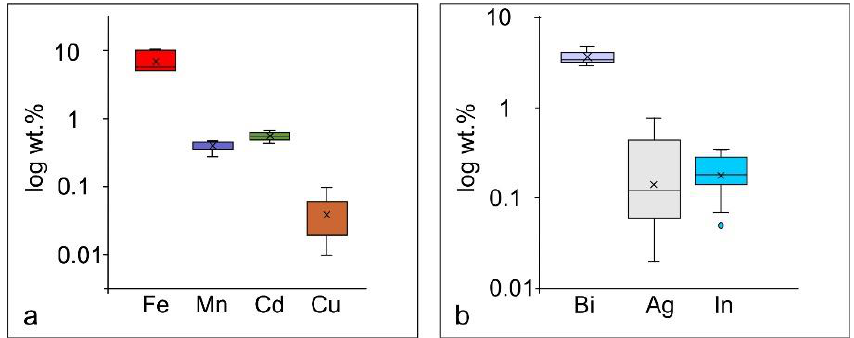
Figure 11. Variations in the trace element content of ( a ) Sphalerite; ( b ) Galena from the Sasa Pb-Zn-Ag skarn deposit.